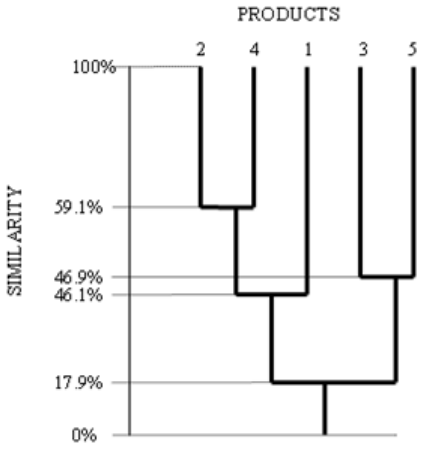
Figure 2. Dendogram representing successive grouping